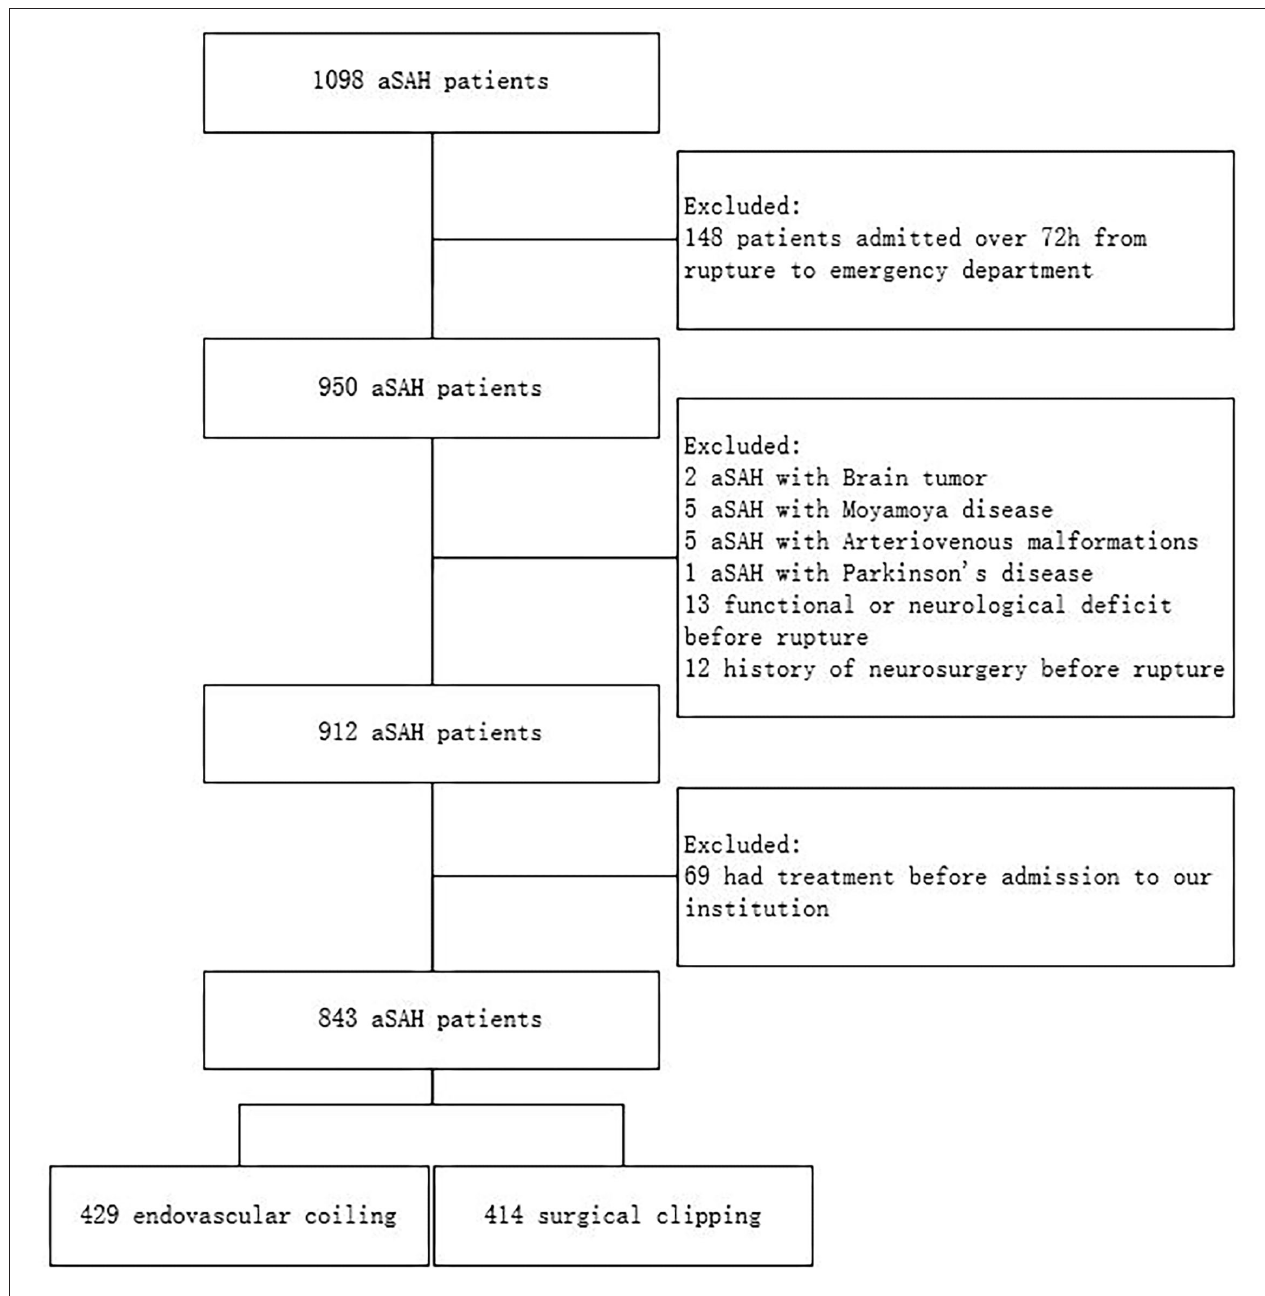
FIGURE 1 | Flowchart of patient